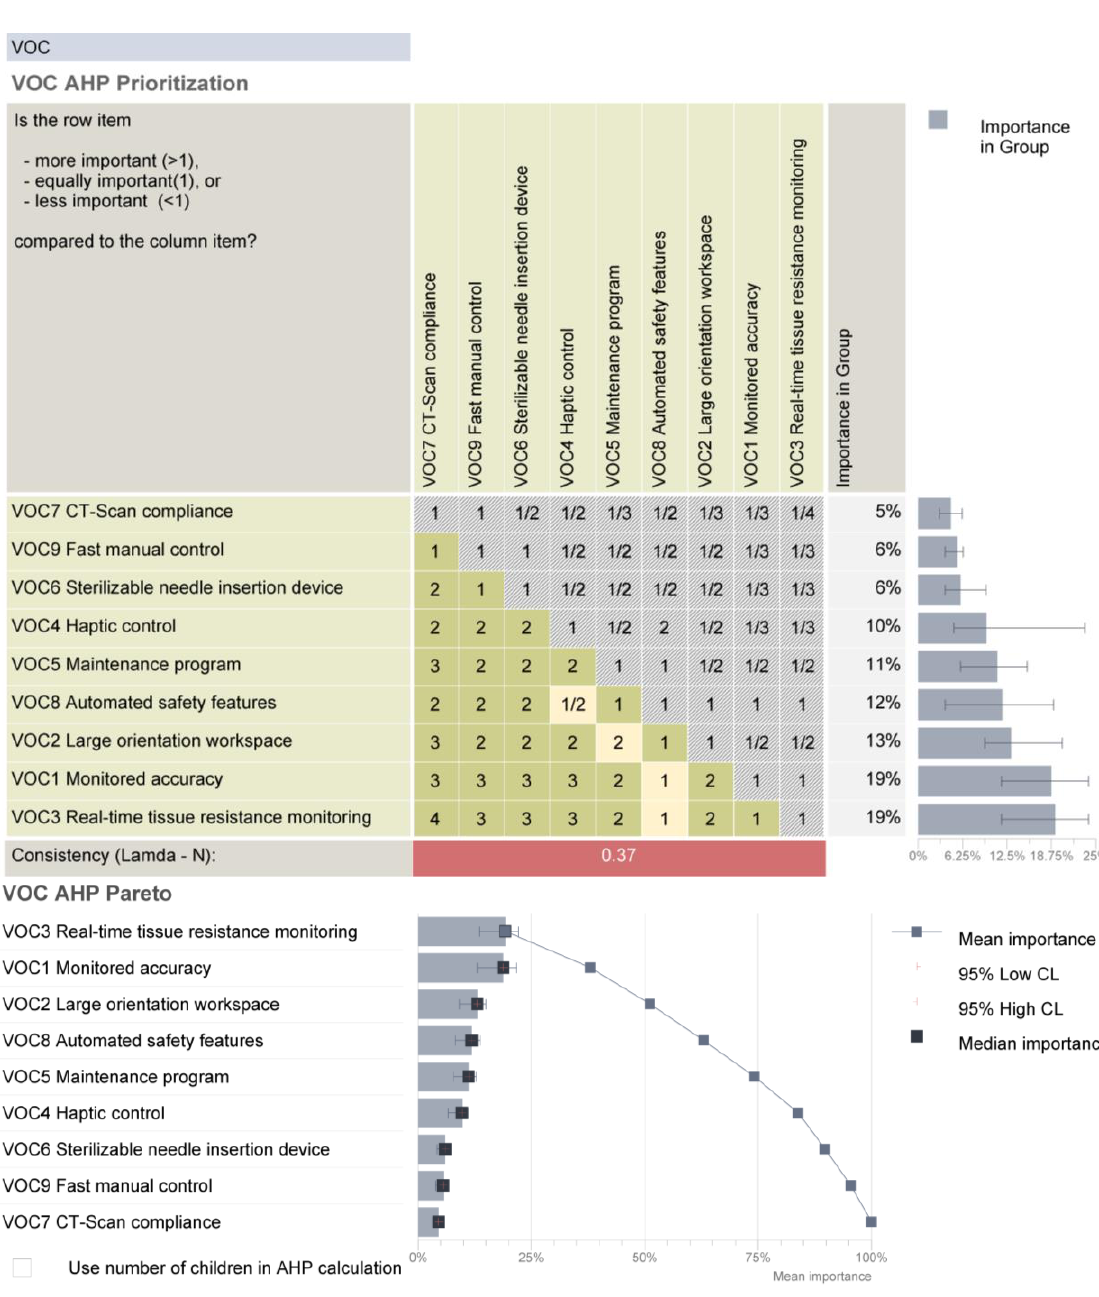
Figure 5. The prioritized requirements for the brachytherapy robotic system.